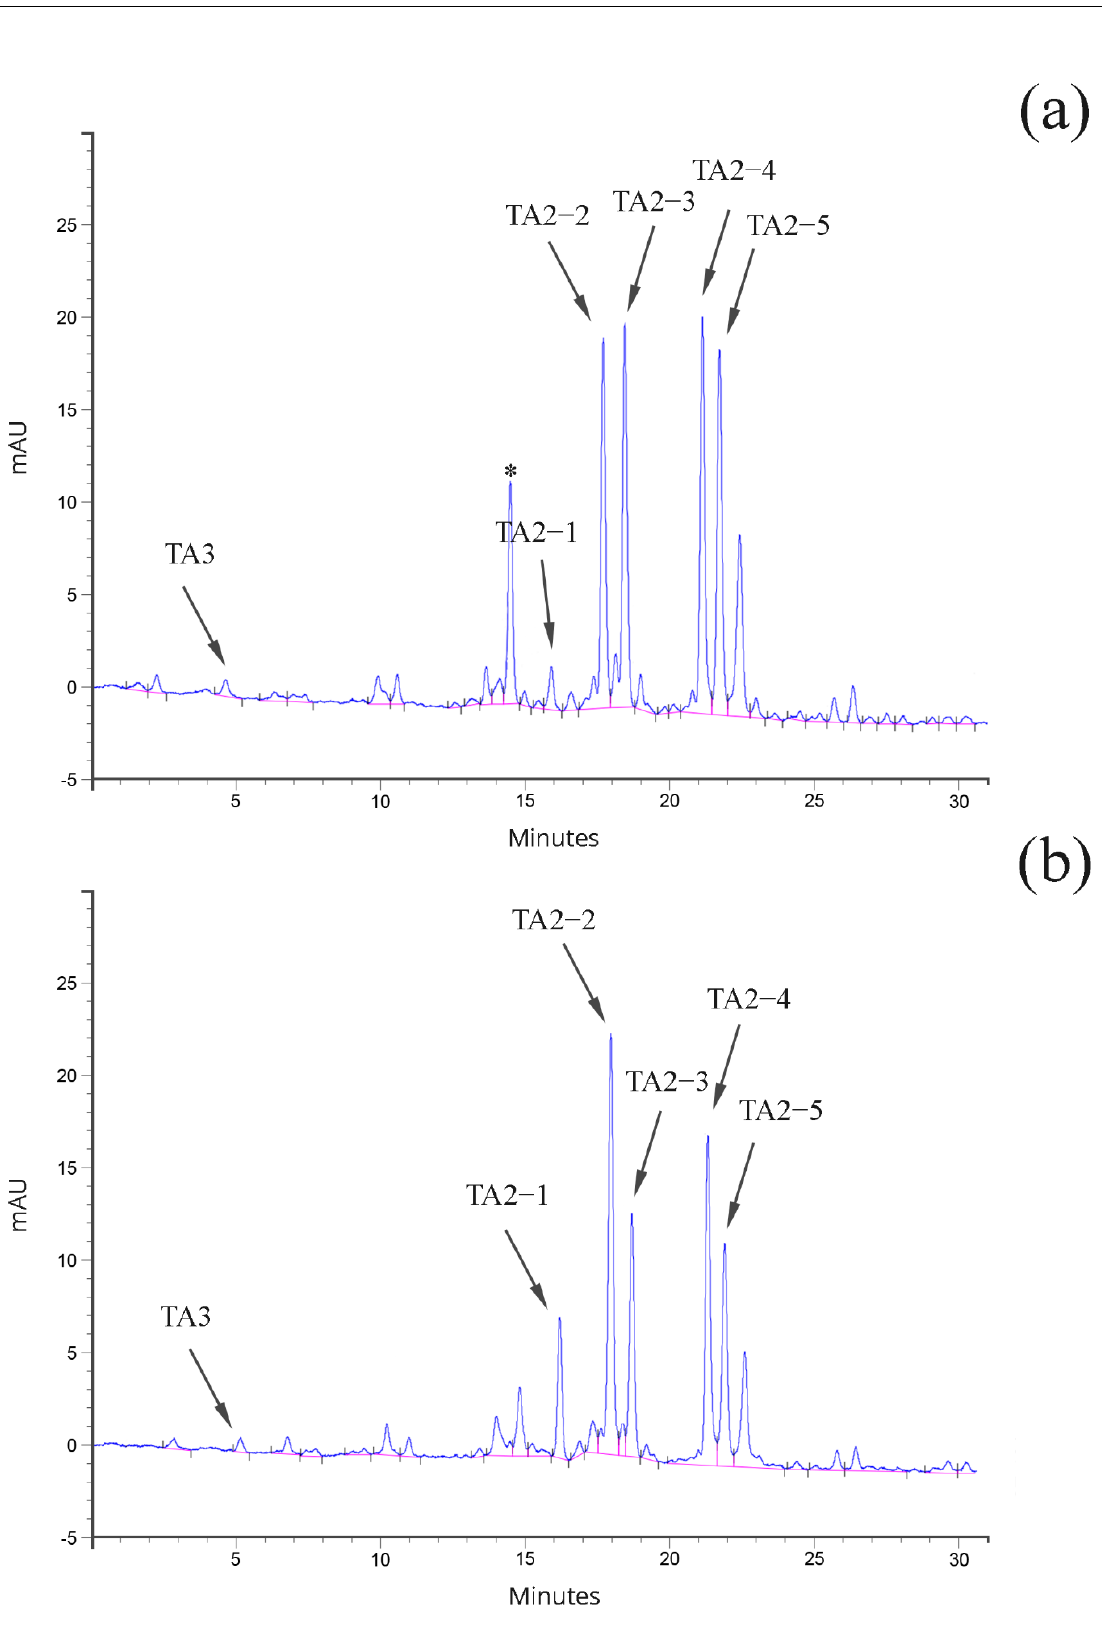
Figure 3. HPLC profile of ( a ) Ph. Eur. out of specification teicoplanin (from the hyphae-derived clone H46), and ( b ) Ph. Eur. compliant teicoplanin (from the protoplast-derived clone P75). Noteworthy is the increase in uncharacterized peaks marked by asterisks in panel ( a ).